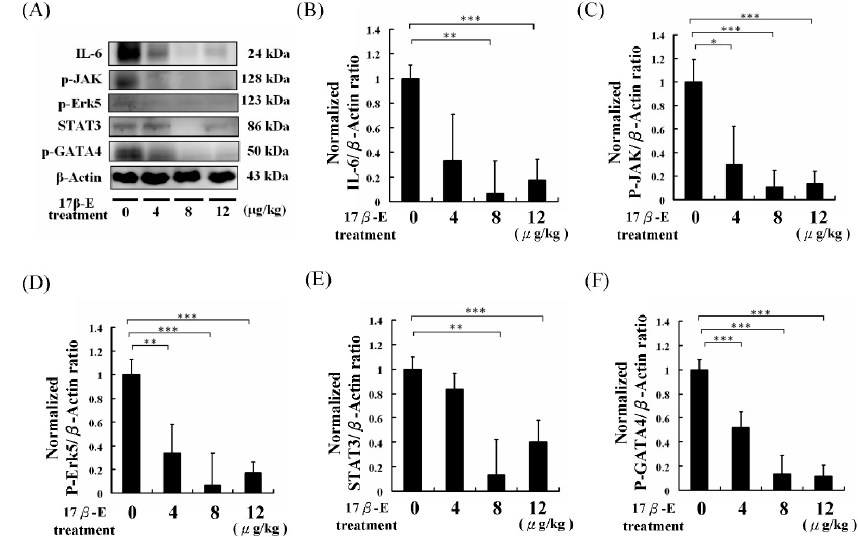
Figure 4. The cardiac hypotrophy and CVD risk biomarker protein analysis of 60 days of different doses of 17 β -estradiol treatments (0, 4, 8, 12 μ g/kg/day) for high-fat diet-fed male C57B mice heart protein samples. ( A ) The hearts protein samples Western blotting analysis results of IL-6, p-JAK, p-Erk5, STAT3, p-GATA4, and β -actin. ( B ) The normalized protein expression of IL-6/ β -actin. ( C ) The normalized protein expression of p-JAK/ β -actin. ( D ) The normalized protein expression of p-Erk5/ β -actin. ( E ) The normalized protein expression of STAT3/ β -actin. ( F ) The normalized protein expression of p-GATA4/ β -actin. (* = p < 0.05, ** = p < 0.01, *** = p < 0.001 compared with the control, n = 6 in each group.)